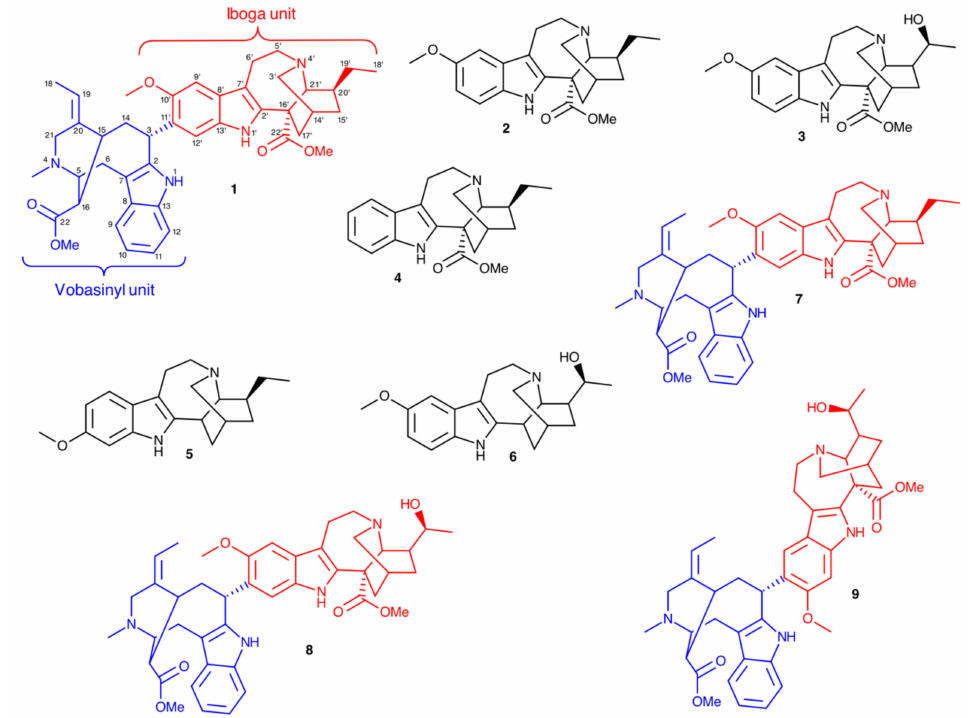
Figure 1. Chemical structures of compounds 1 – 9 . For the bisindoles ( 1 , 7 – 9 ), the vobasinyl and iboga subunits are highlighted in blue and red,